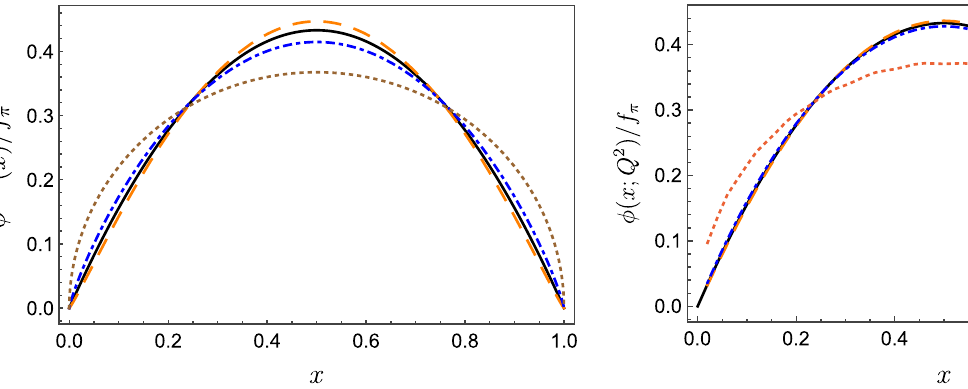
Fig. 4 The pion DA. Full lines represent the asymptotic pQCD pre- diction whose expression is in Eq. (50). Dashed lines for the GSWL2 parametrization. Dot-Dashed line for GSWL1 and dotted lines for the